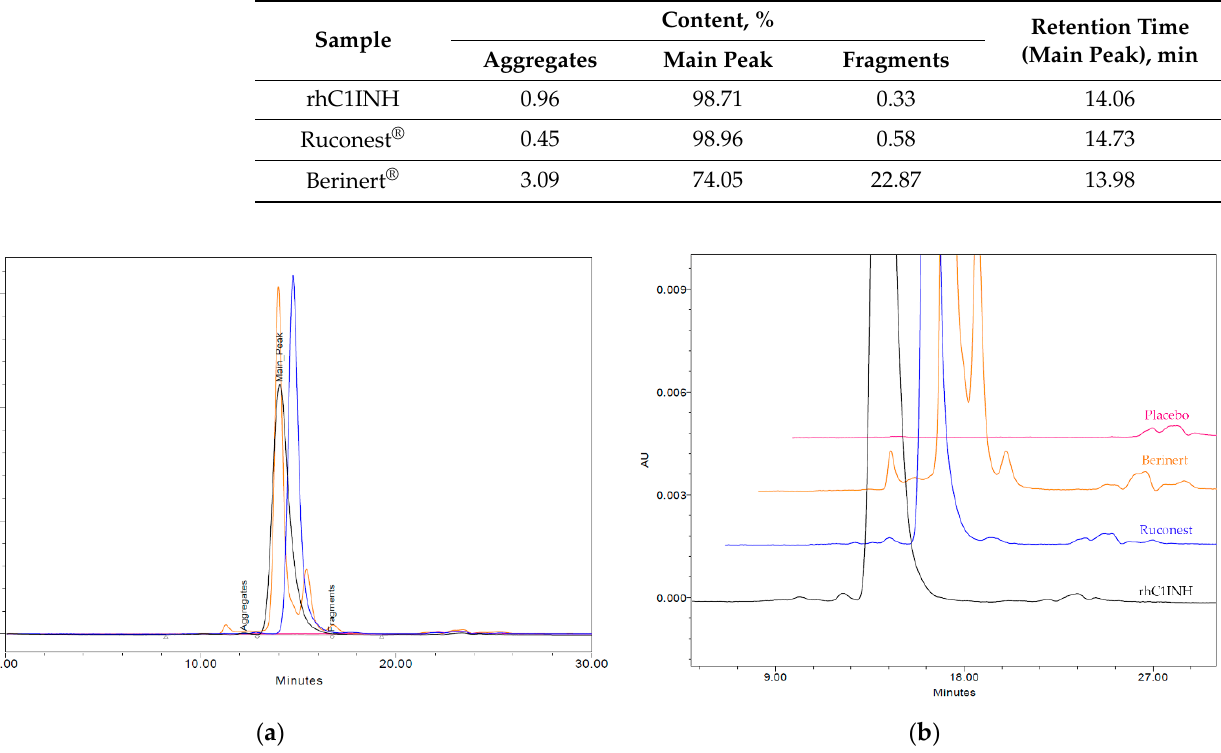
Figure 5. Comparison of size-exclusion chromatograms of the rhC1INH (black line), Berinert ® (yellow line), Ruconest ® (blue line) and placebo buffer (red line); ( a ) full view of the chromatogram, ( b ) enlarged view of impurities peaks.